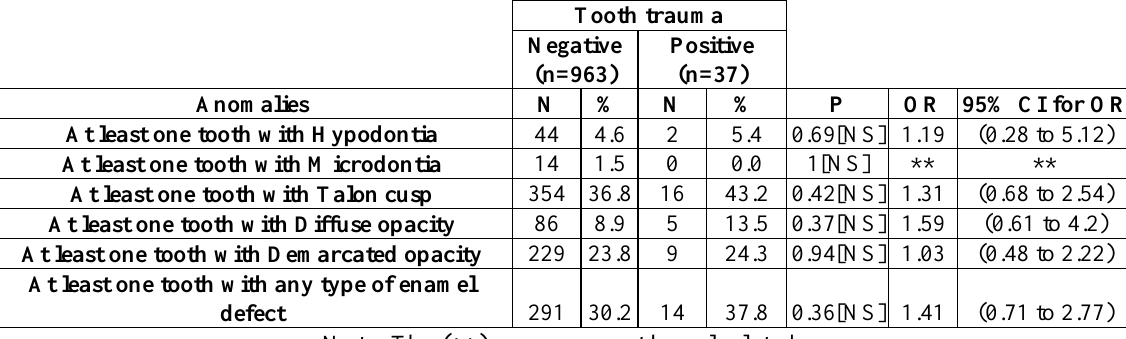
Table 3: The relationship between tooth trauma and dental anomalies